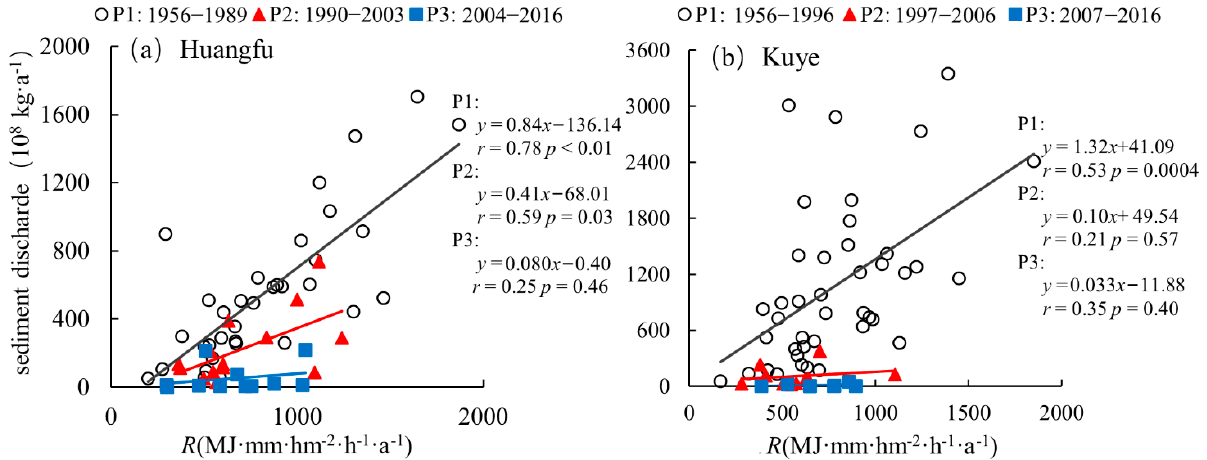
Figure 5. Relationships between annual rainfall erosivity and sediment discharge in baseline and change periods in the Huangfu basin ( a ) and the Kuye basin ( b ).